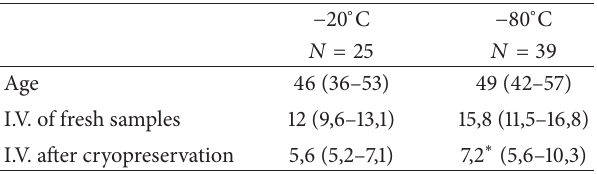
Table 2: Viability index at different temperatures of cryopreserva- tion. The viability index (I.V.) of cryopreserved samples was signifi- cantly higher at − 80 ∘ C compared to − 20 ∘ C, 𝑝 < 0.05